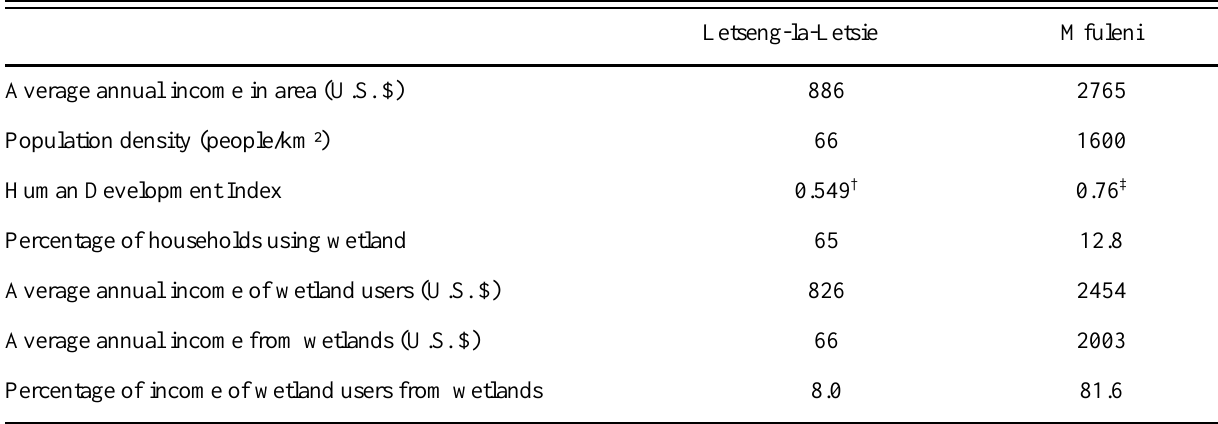
Table 6 . Average incomes earned in Letseng-la-Letsie and Mfuleni and their relative dependency upon the wetlands.